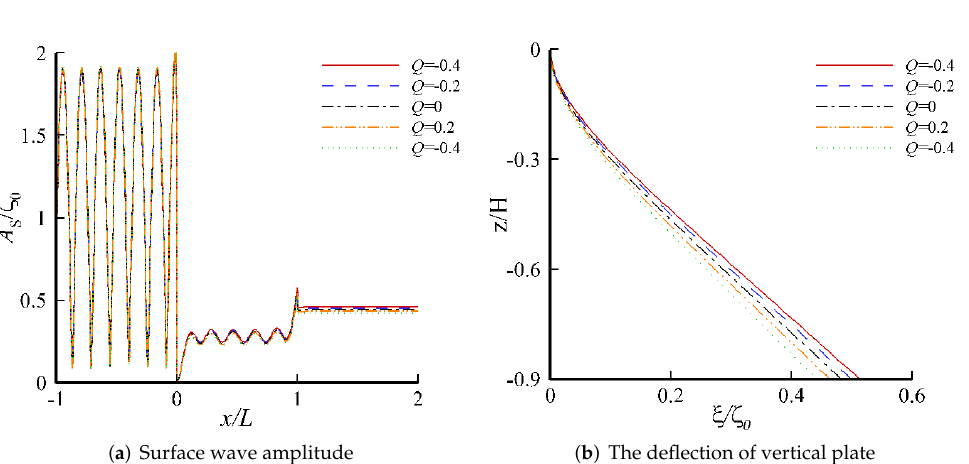
Figure 11. Wave amplitudes A S ( x ) and deflection of vertical plate ξ ( z ) for the different lateral stress Q